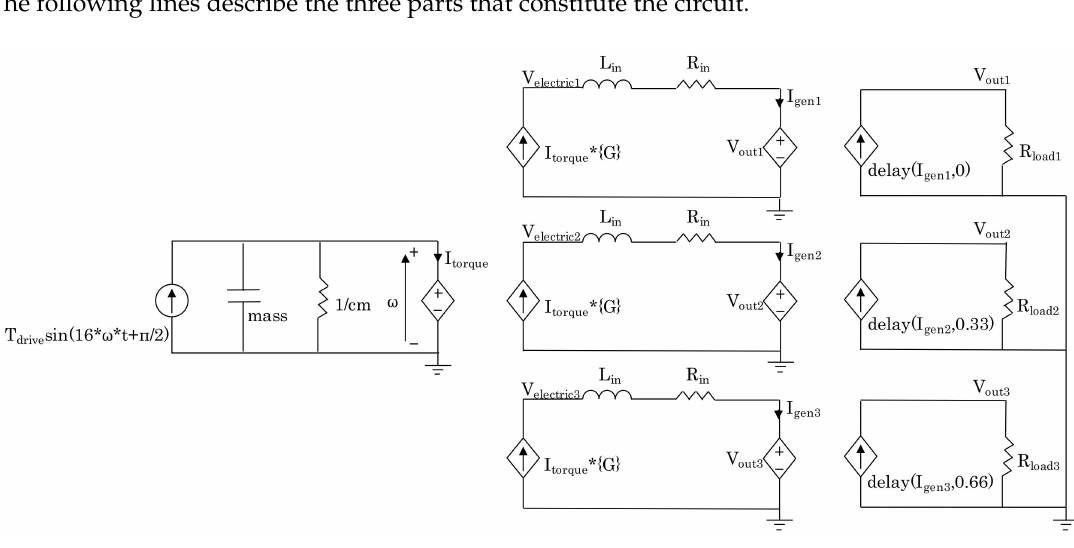
Figure 16. Schematic of mini wind harvester